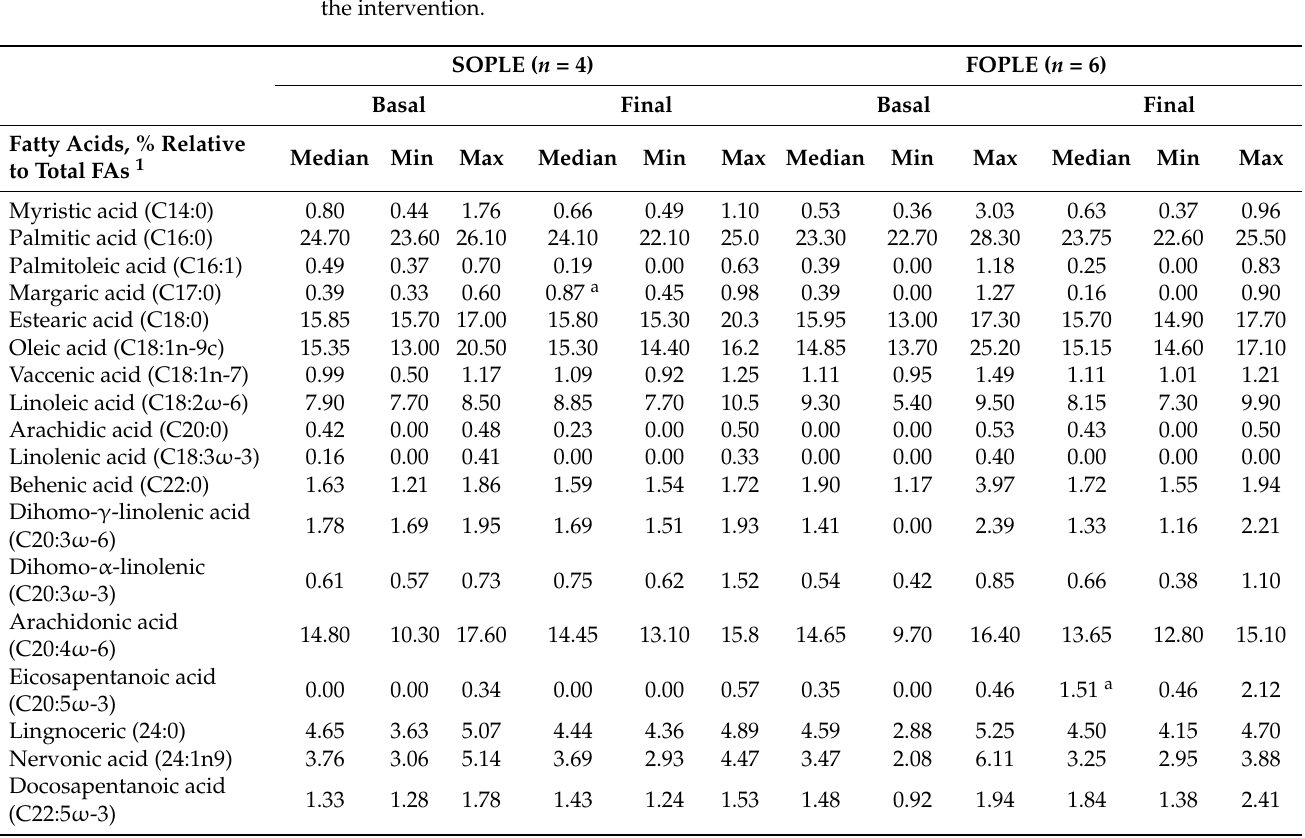
Table 4. Fatty acid profile of the red blood cell membrane from subjects in SO-based parenteral lipid emulsion (SOPLE) and FO-based parenteral lipid emulsion (FOPLE) formula groups before and after the intervention. SOPLE ( n = 4) FOPLE ( n = 6) Basal